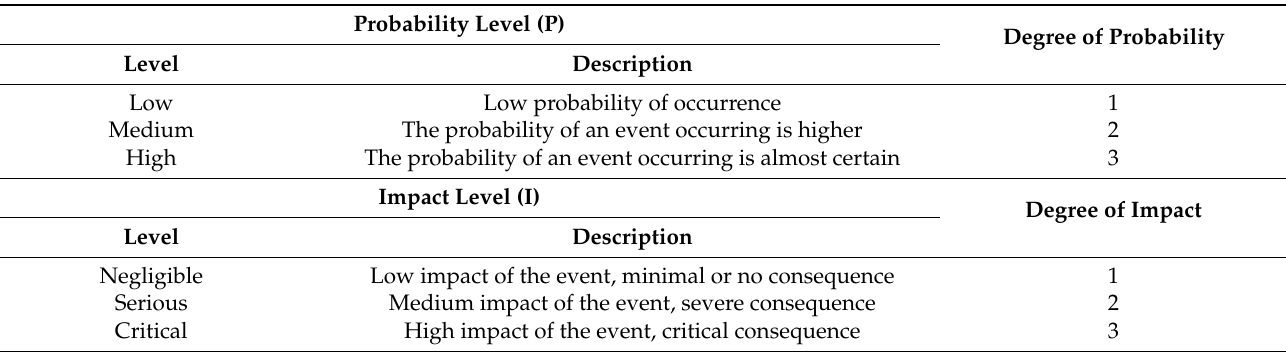
Table 7. Characteristics of the risks’ probability and